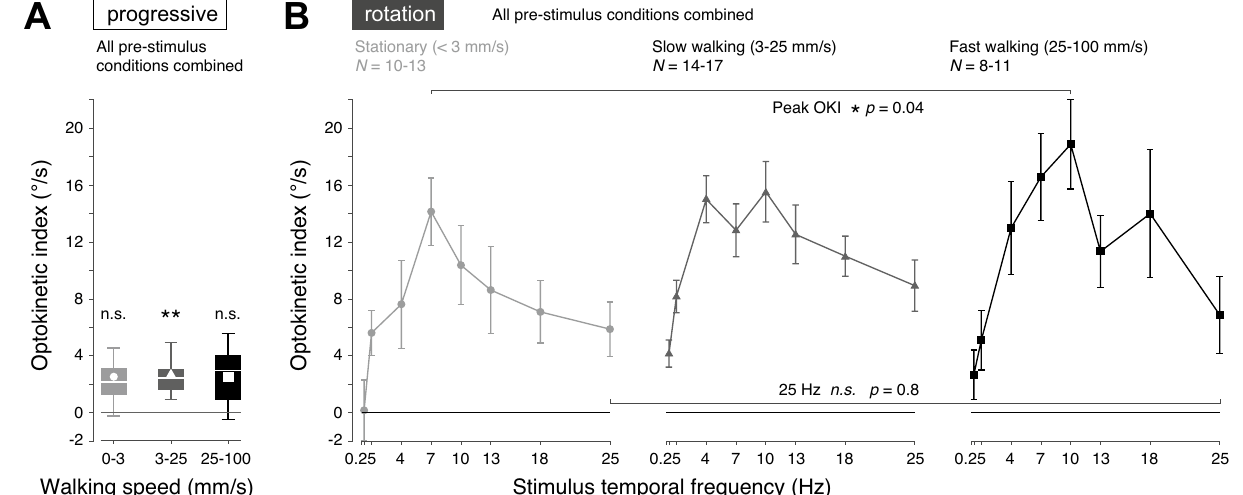
Figure 6. Impact of walking speed on temporal frequency tuning of the OKI. ( A ) OKI during pre-stimulus progressive image motion (‘progressive’), for all flies that contributed trials to the OKI during the stimulus period of rotational image motion, shown in ( B ), grouped by walking speeds (left to right): stationary (< 3 mm/s); slow walking (3–20 mm/s); fast walking (20–100 mm/s). The walking speeds are indicated by the greyscale intensity and symbols. Mean ± S.E.M. shown, and the range of the number of flies contributing trials per stimulus temporal frequency were: N = 10–13 (stationary), N = 14–17 (slow walking), N = 8–11 (fast walking). ( B ) OKI during the stimulus rotational image motion (‘rotation’), for all flies grouped by walking speed as in A. Mean ± S.E.M. shown. The range of the number of flies contributing trials per stimulus temporal frequency were as in ( A ), and indicated. The temporal frequency tuning of the OKI of stationary flies is qualitatively maintained over a range of walking